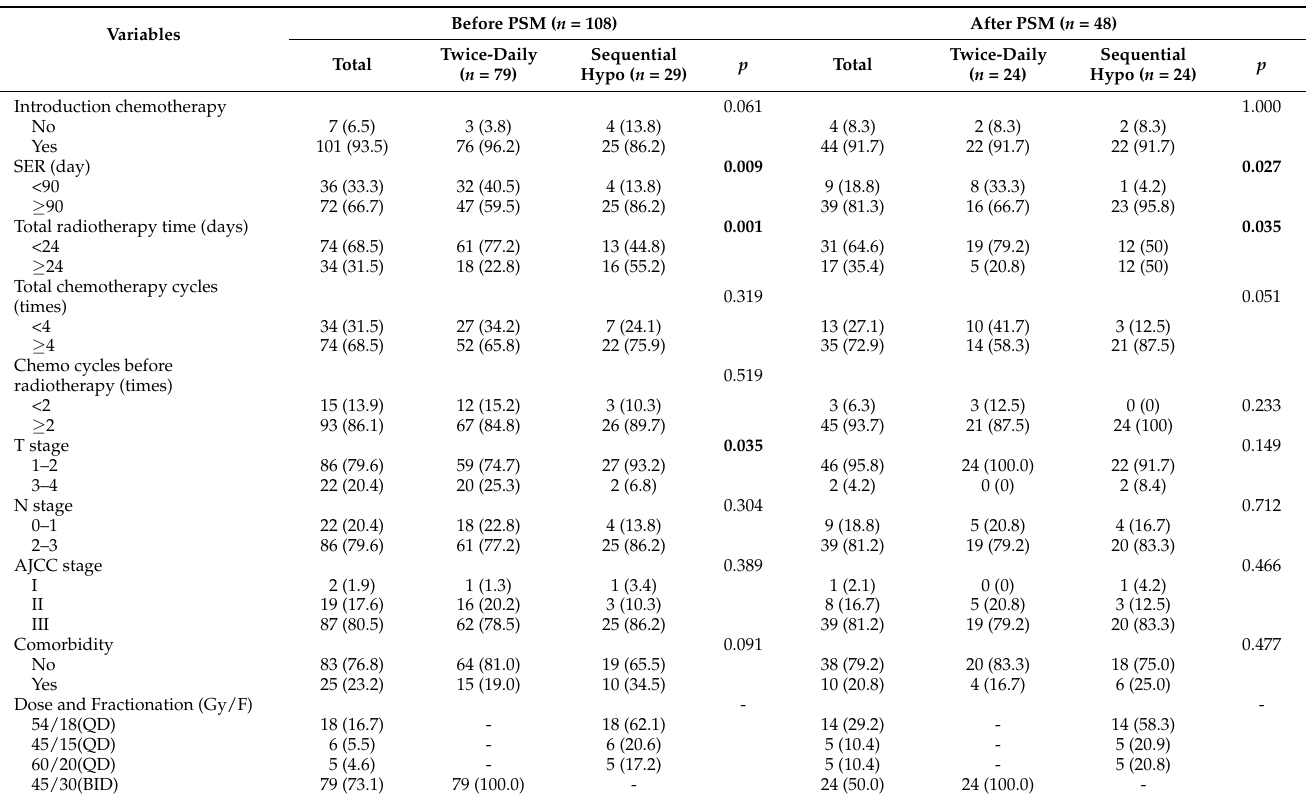
suffer recurrence than others (HR = 1.774, p = 0.048). An N stage of 2–3 was a poor prognostic indicator for RFS (Supplemental Figure S2) and DMFS (Supplemental Figure S3) (HR = 2.369, p = 0.047; HR = 3.032, p = 0.011,